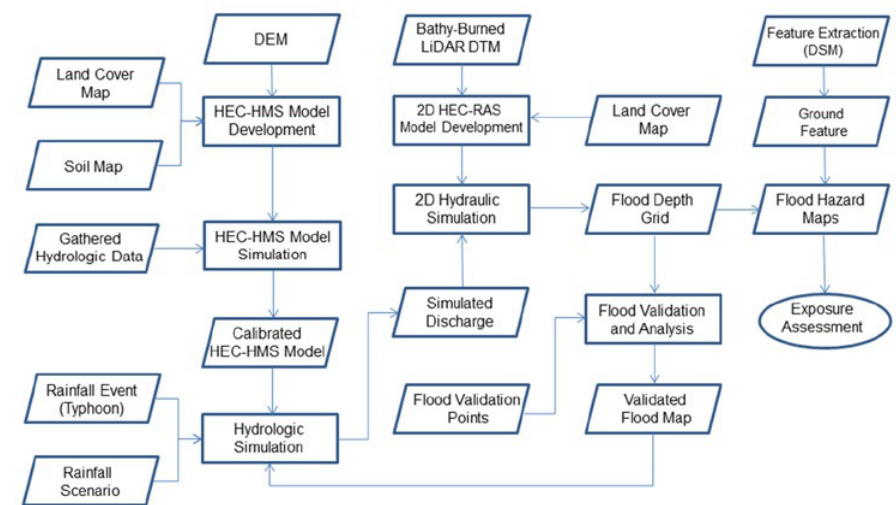
Fig. 2: Process flow of flood hazard mapping